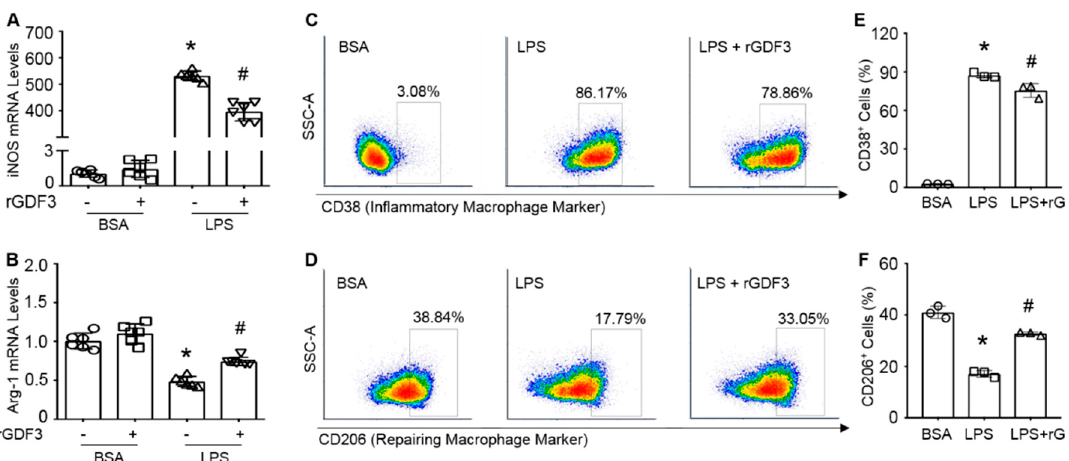
Figure 4. Recombinant GDF3 protein reduces macrophage M1 and increases M2 polarization in LPS-treated BMDMs. BMDMs were treated with rGDF3 (50 ng / mL) for 2 h, then added LPS (10 ng / mL) for 6 h. mRNA levels of ( A ) iNOS and ( B ) Arg-1 were evaluated by RT-PCR. The mRNA levels were normalized to 18S mRNA levels and expressed as fold versus BSA group (*, p < 0.05 vs. Ctl; #, p < 0.05 vs. LPS; n = 6). ( C , D ) BMDMs were treated with rGDF3 (50 ng / mL) for 2 h, followed by LPS (10 ng / mL) exposure for 12 h. These BMDMs were stained with antibodies to ( C ) CD38 and ( D ) CD206 for flow cytometry analysis. Quantification results for ( E ) CD38 positive macrophages and ( F ) CD206 positive macrophages. (*, p < 0.05 vs. BSA; #, p < 0.05 vs. LPS; n = 3). Similar results were obtained in other two separated experiments.